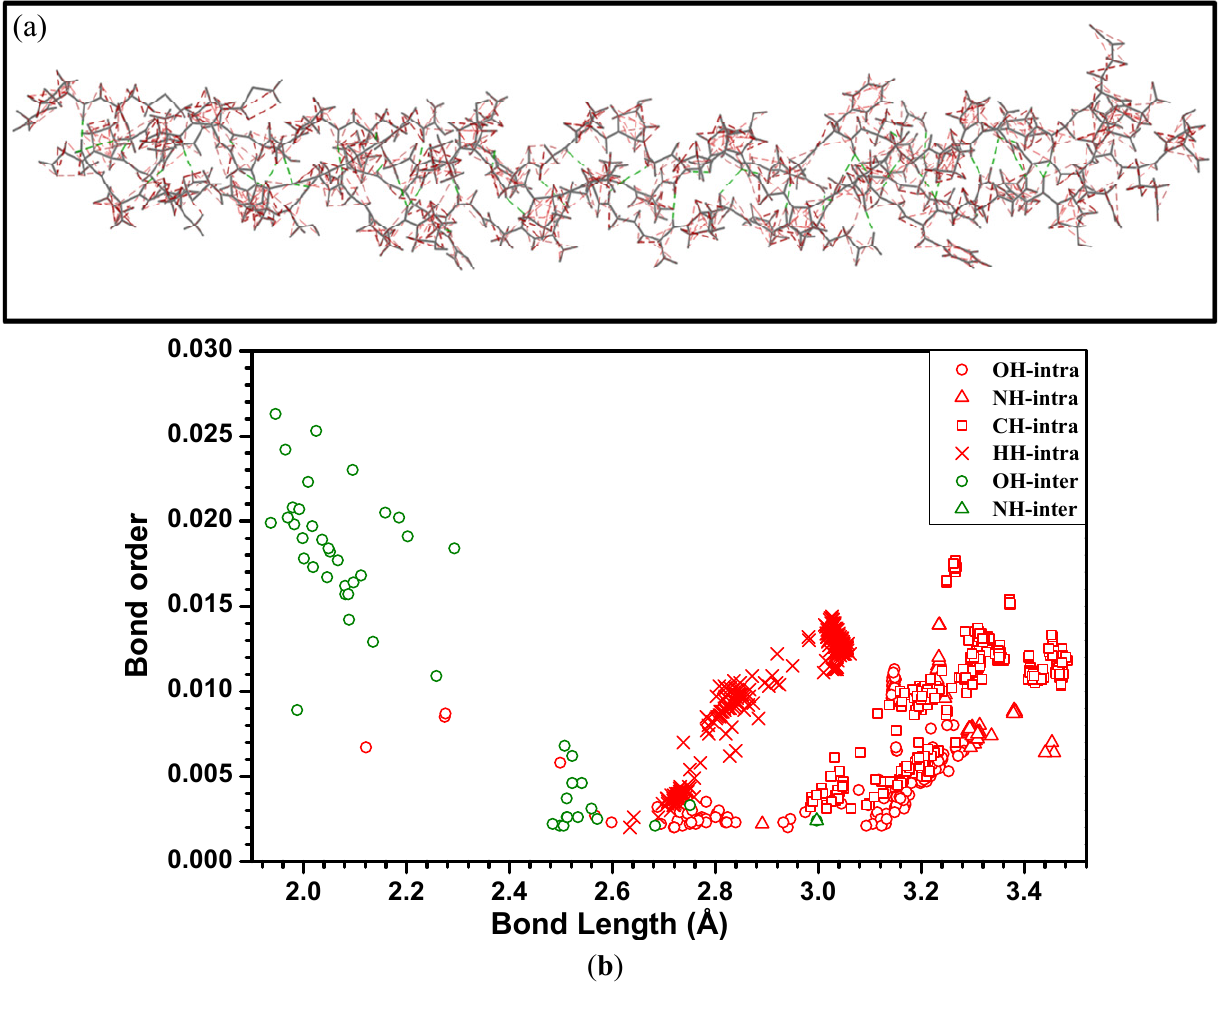
Figure 6. (Color on-line) ( a ) Sketch of H-bonds within the 7-2 heterostructural model. Green dashed lines for intermolecular H-bonding and red dashed line for the intra-molecular H bonding; and ( b ) Distribution of the calculated BO values for H-bonds in the 7-2 heterostructural model. Different types of the H-bonding are marked and colored as